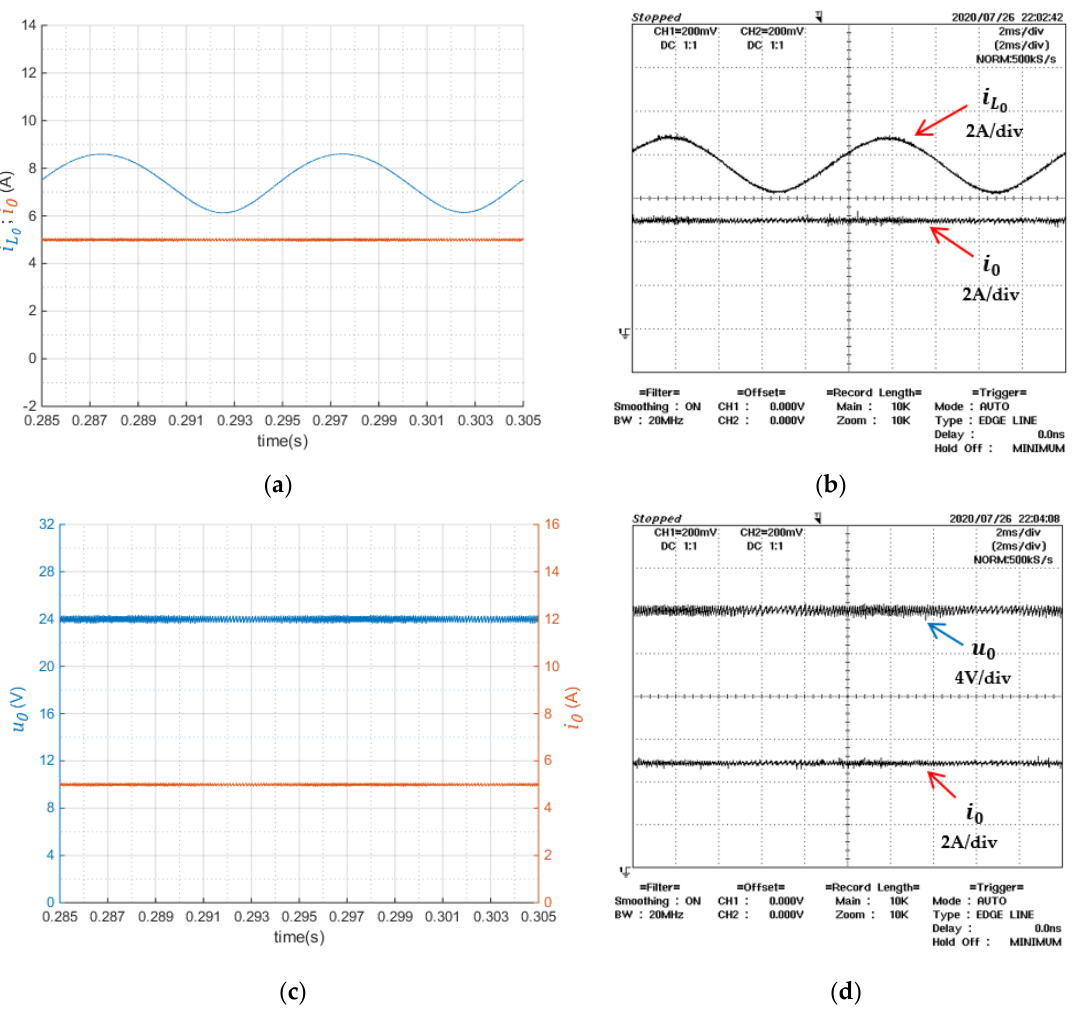
Figure 12. Waveform at output side of the AC-DC converter: ( a ) simulation results of current 𝑖 𝐿 current 𝑖 0 ; ( b ) experimental results of current 𝑖 𝐿 and current 𝑖 0 ; ( d ) simulation results of voltage 𝑢 0 and current 𝑖 0 .